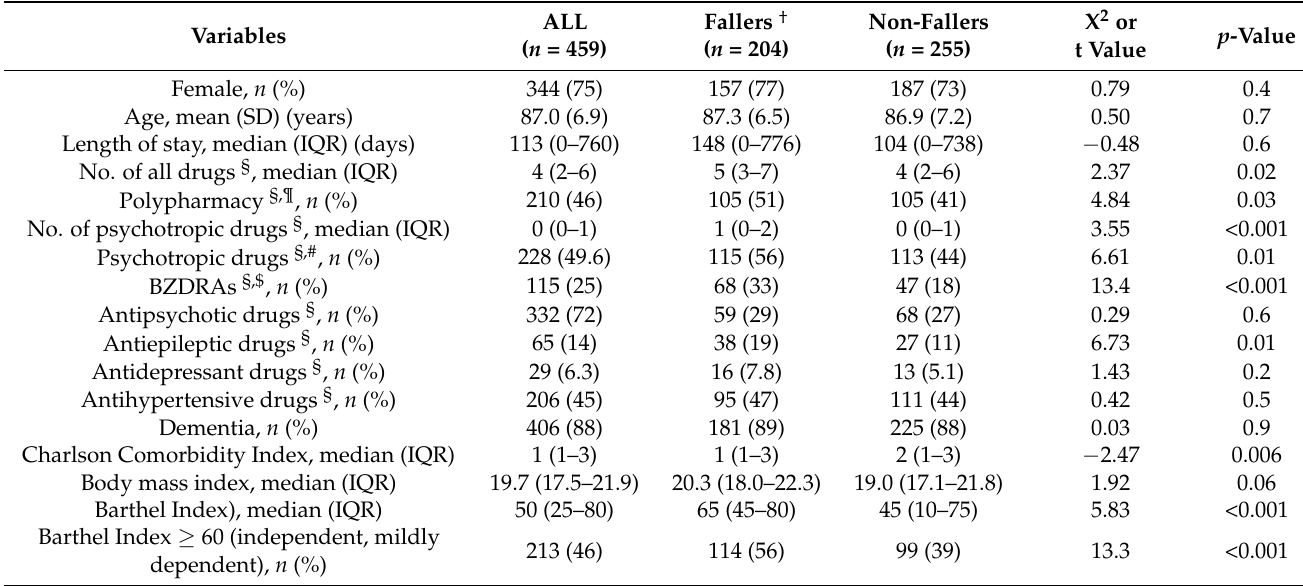
Table 1. Characteristics of